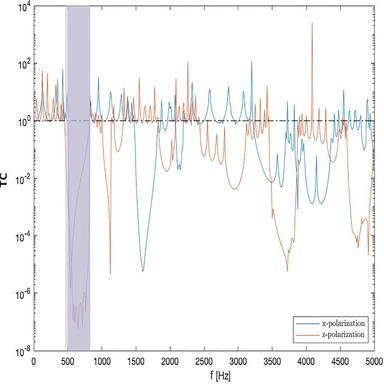
Transmission curves for both pressure and shear waves.